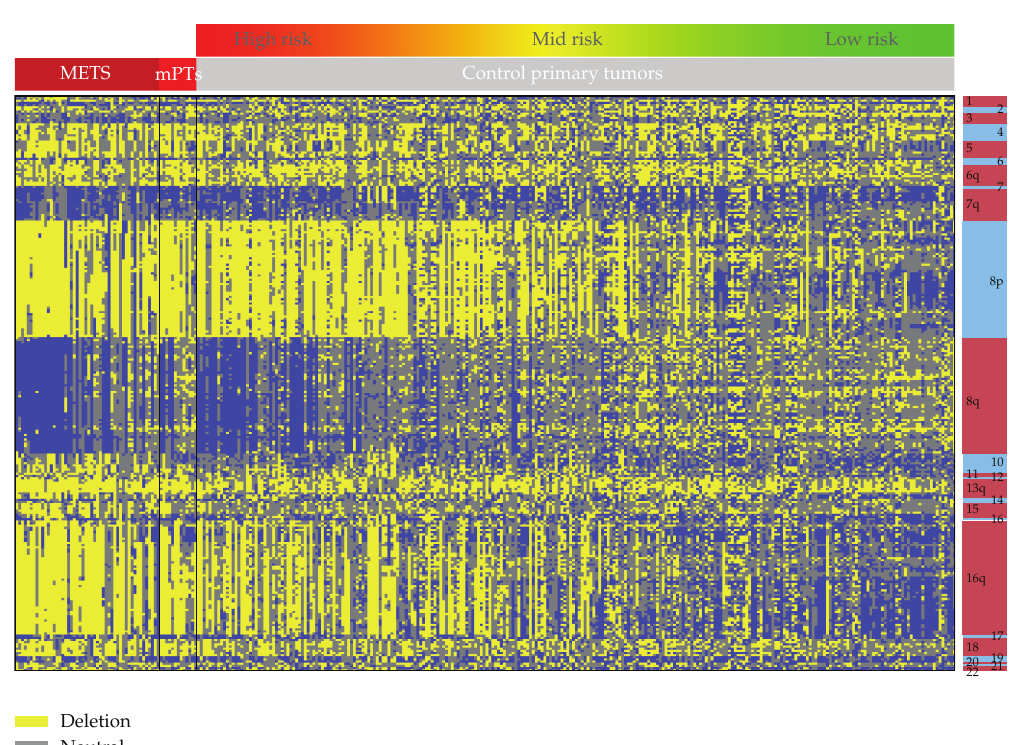
Figure 10: Heatmap showing copy number amplifications and deletions for tumor samples in the gene signature. The genes are arranged in genomic order; position is indicated by the colored bar on the right. The tumor samples (cid:2) x -axis (cid:3) are arranged by subtype (cid:2) metastatic (cid:2) METS (cid:3) , progressors (cid:2) mPTs (cid:3) , and control primary tumors (cid:3) and further sorted by their metastatic potential score. A strong pattern emerges in the metastasis samples on the left and is shared by the progressors and high-risk primary tumors. Further towards the right, the metastatic pattern diminishes and even shows a reversal in copy number pattern in some chromosomal